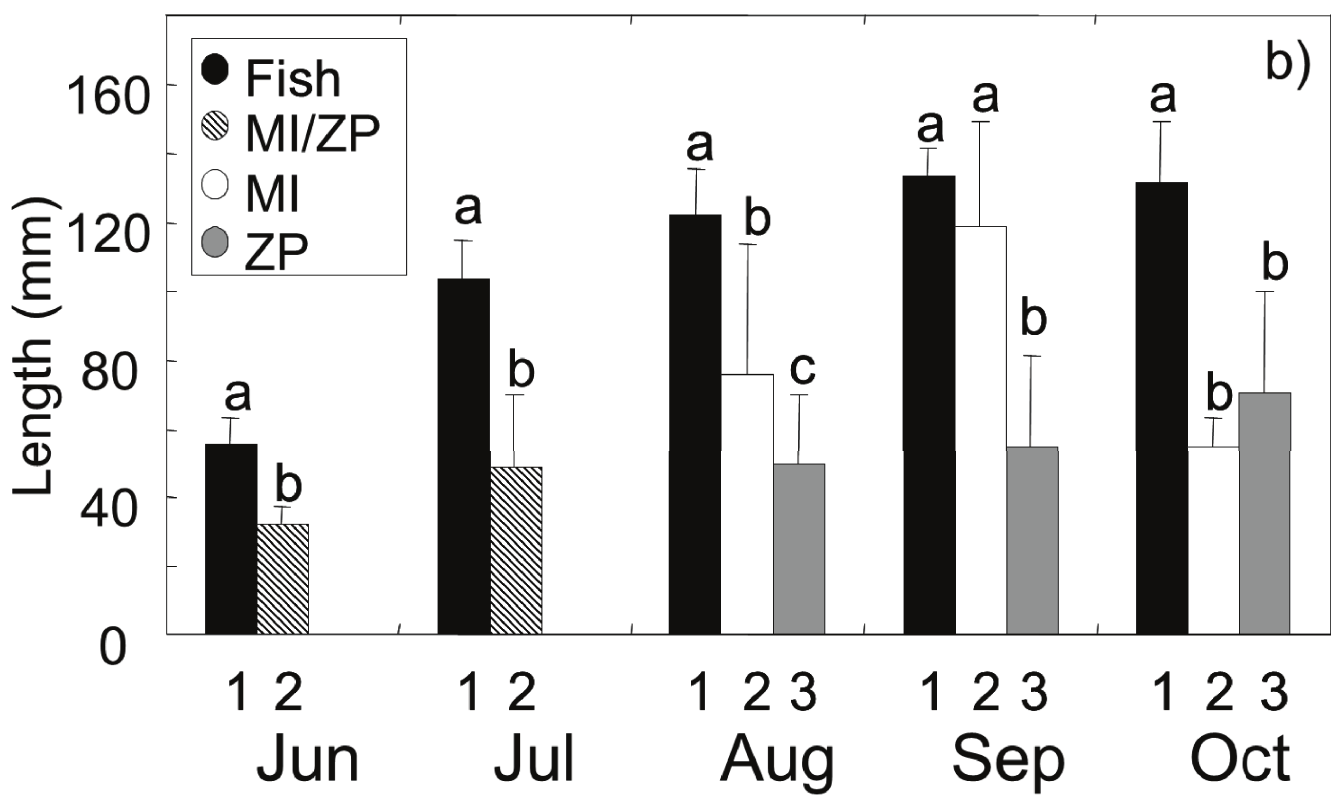
Fig 2. Mean length [mm] of perch in different clusters. The calculationof clusters was basedon stomach content analysis(Fig 1). Different shades indicate the food resource mainly used by perch in the cluster, letters indicatesignificantdifferences of length betweenclusters (basedon Student’s t-tests for June and July and one-wayANOVA and Bonferroni post hoc tests for pairwisecomparisonfor the other samplingdates). Error bars give the standard deviation(SD). MI = macroinvertebrates, ZP = zooplankton.